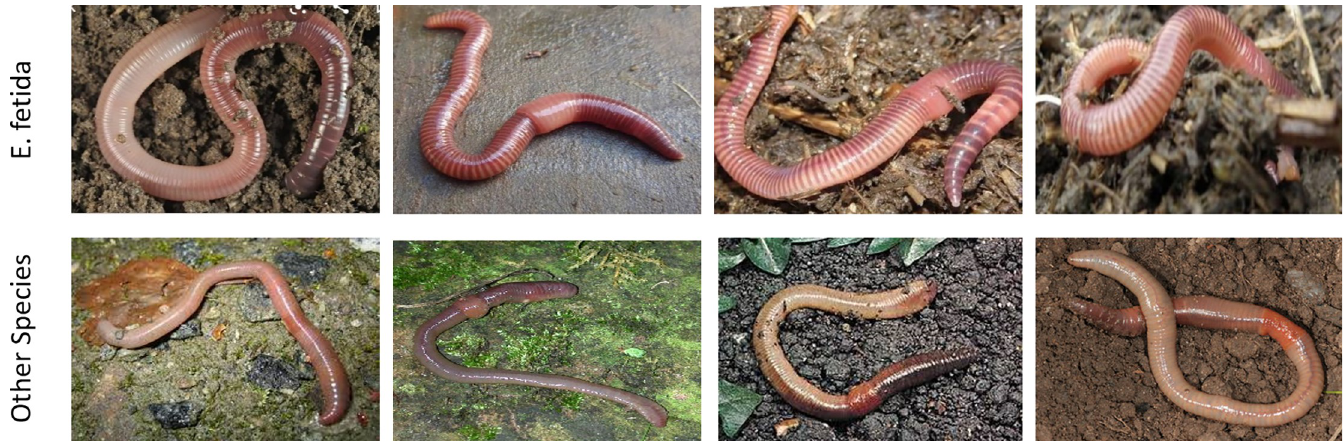
Fig 3. Some of the images of earthworm species ( E. fetida and other) used to test ESIDE in a real use under the supervision of a qualified taxonomist.